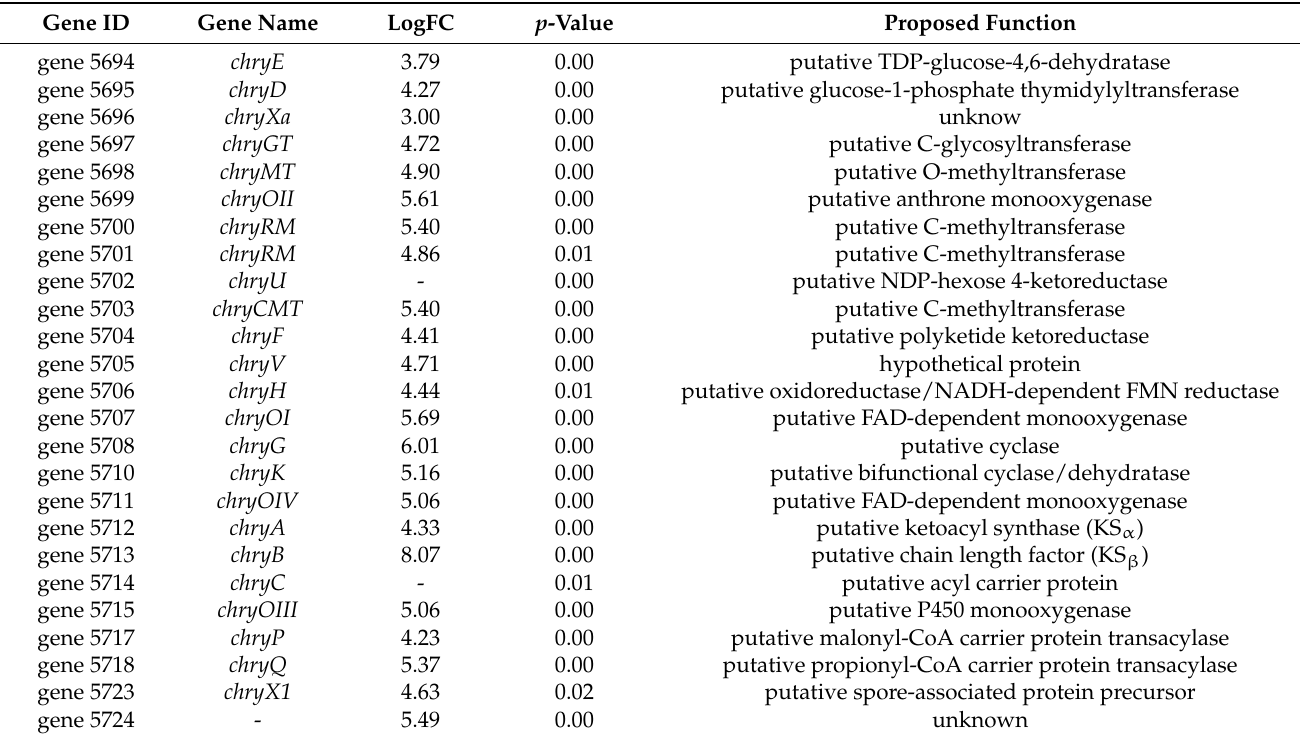
Table 1. The up-regulated genes in chrysomycin BGC for mutant